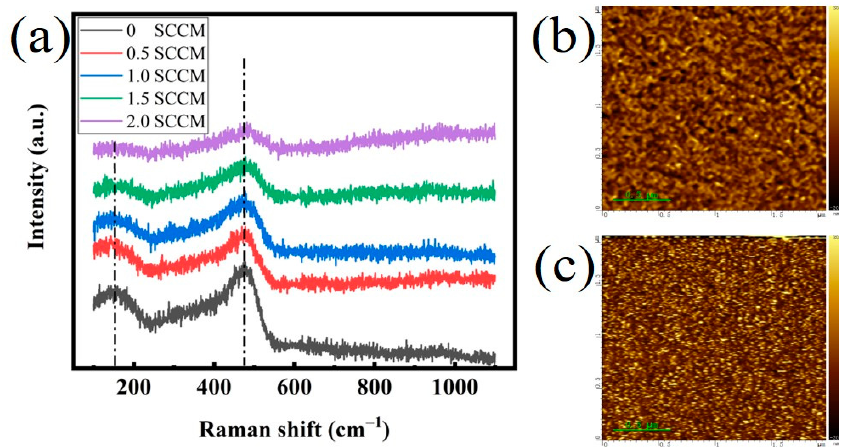
Figure 2. Emission peak position ( a ) and the full width at half maximum ( b ) with the variation of the excitation wavelength for the films prepared at different NH 3 flow rates, respectively.